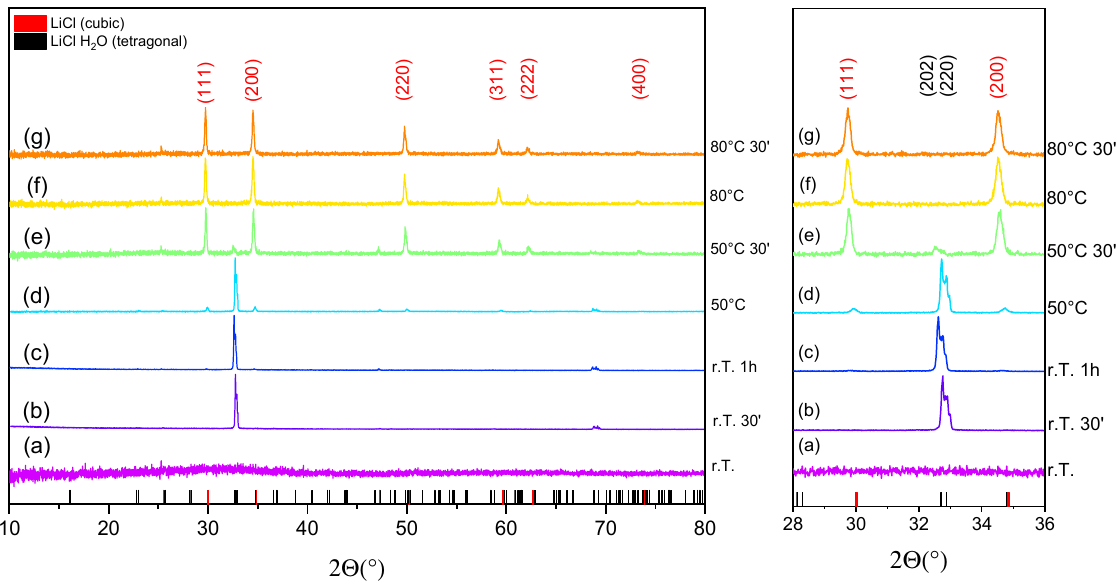
Figure 2. Three-dimensional optical image of ( a ) cross-section area of LiCl-PDMS foam at 50× magnification. ( b ) Higher magnification of a portion of the foam.